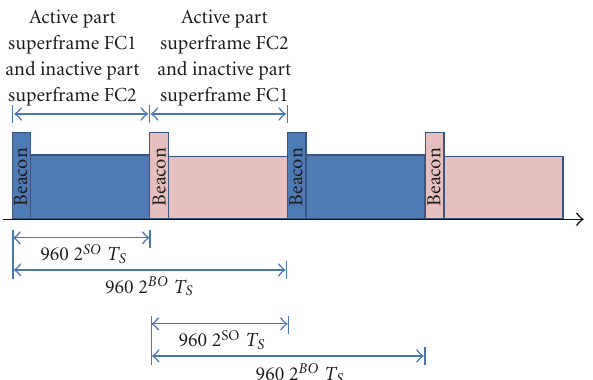
Figure 2: The time division between clusters, when two FCs are present.